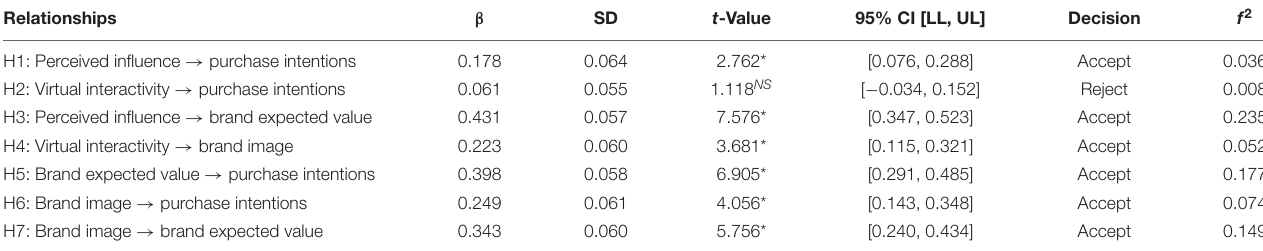
TABLE 5 | Hypotheses testing: direct relationships. Relationships